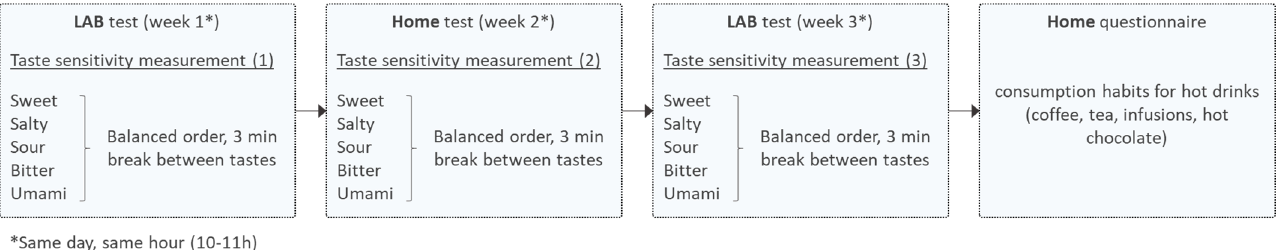
Figure 1. General design of the study.